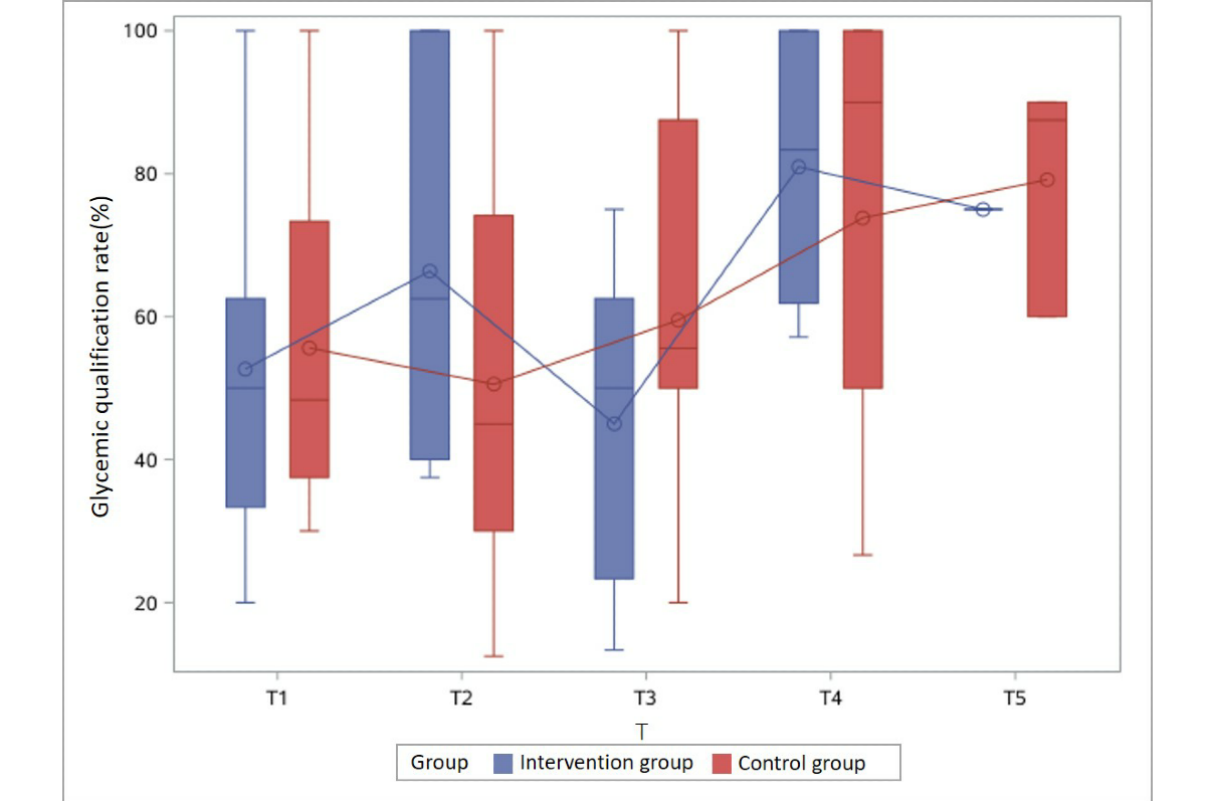
Figure 5. Glycemic qualification rate of the intervention and control groups in Group 4 (enrolled between 29 and 30 [+6] gestational weeks) at different time points. T: 2-week